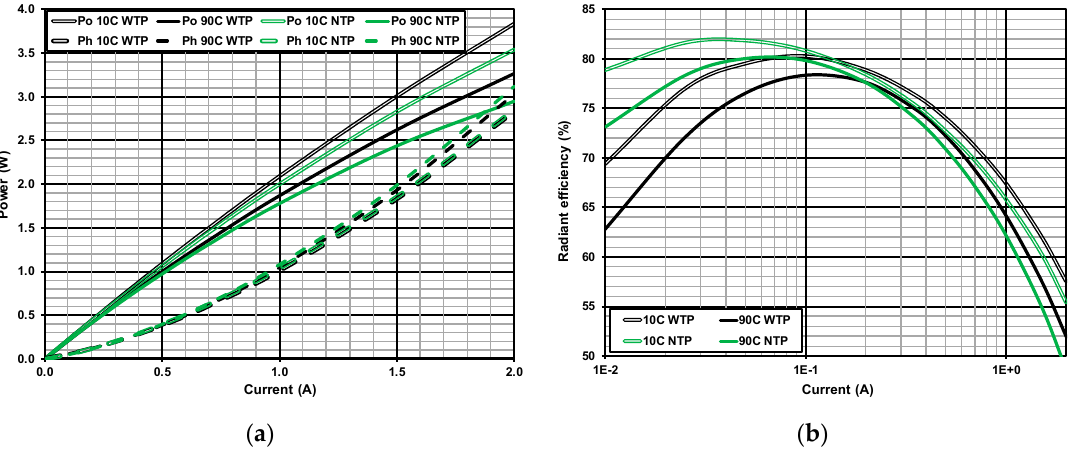
Figure 3. Measured LED power and radiant efficiency for cold plate temperature values of 10°C and 90°C: ( a ) heating and optical power; ( b ) radiant efficiency.